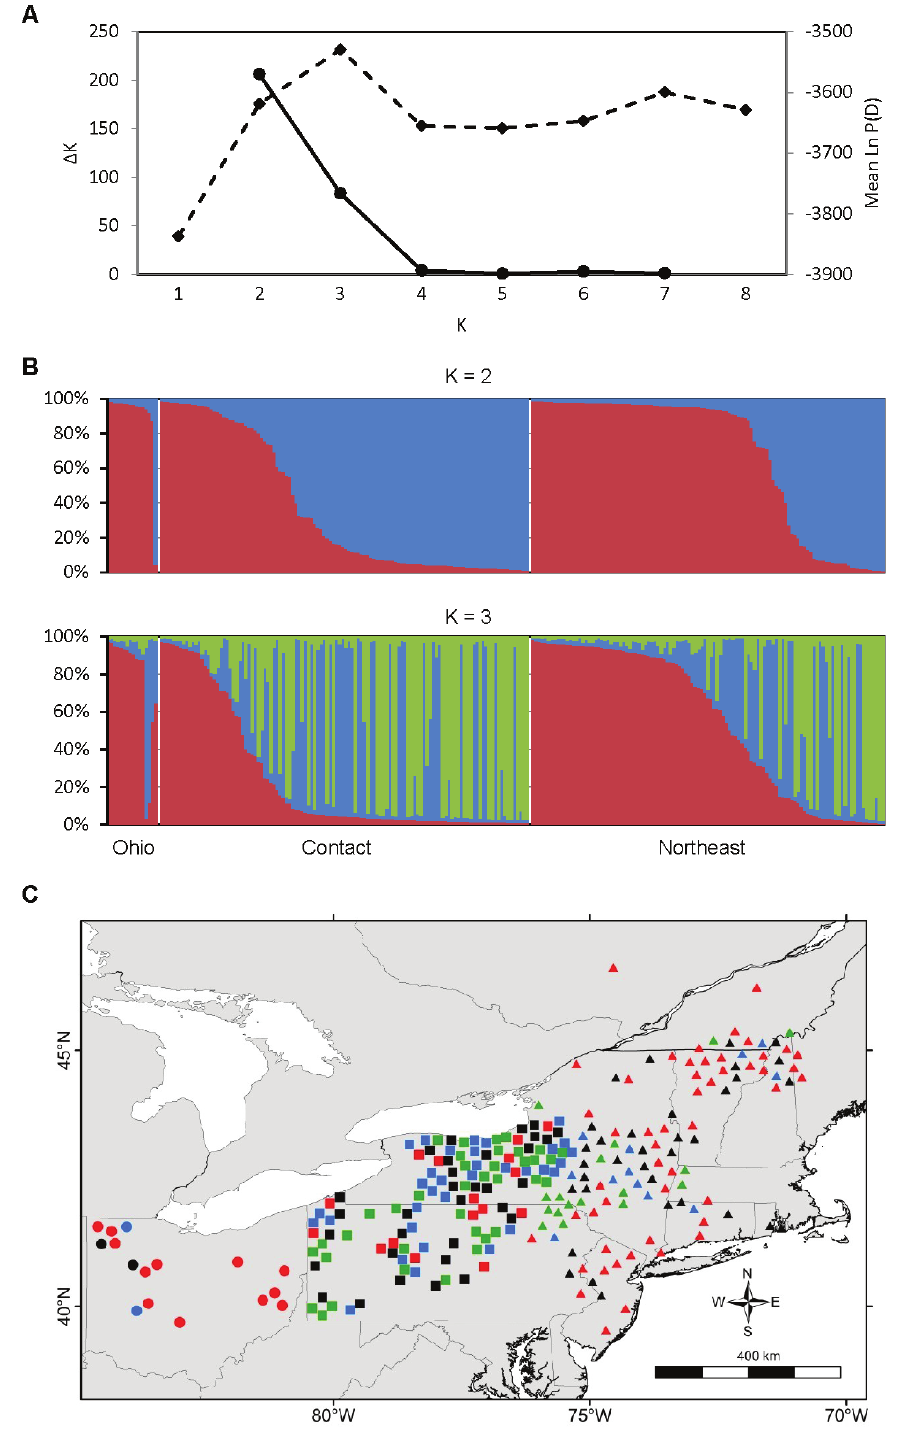
Figure 2. Regional population genetic structure of eastern coyotes. A ) Estimation of the number of genetic populations using two criteria: Δ K (solid line) and Ln P(D) (dashed line). The most probable number of populations is the value of K with the maximal value of Δ K and Ln P(D). The data strongly support K = 2 and K = 3. B ) STRUCTURE bar plots of N = 247 coyotes subdivided into K = 2 and K = 3 genetic populations; each individual is represented by a vertical bar partitioned into two or three colored segments indicating that individual’s proportional membership in each of two or three genetic clusters. C ) Spatial distribution of K = 3 genetic populations. Symbol colors represent the genetic cluster with > 80% assignment from panel B, or black if highly admixed ( i.e. , no assignment > 80%). Symbol shapes represent phylogeographic zones as in Figure 1. Symbol locations are slightly jittered to display each individual and to reduce